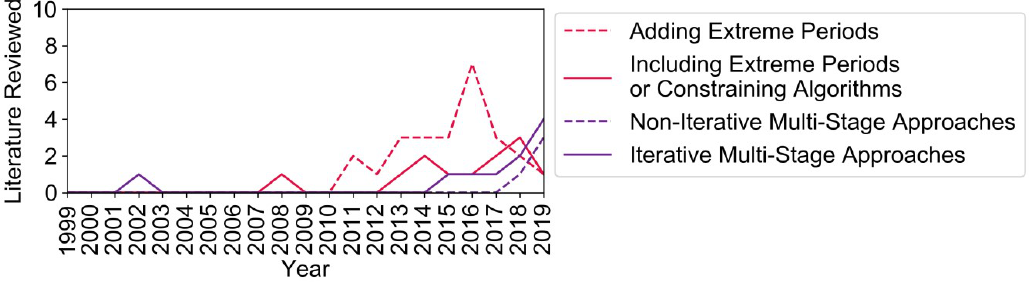
Figure 14. Trends in methods to preserve additional information in time series aggregation (TSA) methods for energy system models (ESMs) based on the major approaches presented in Section 4.